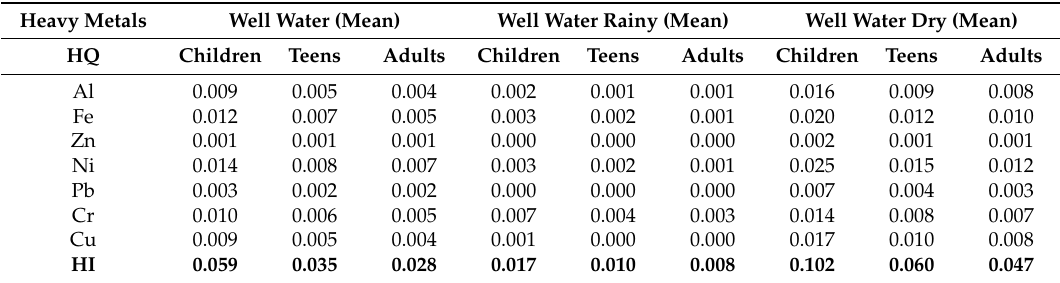
Table 3. Hazard quotient (HQ) and hazard Index (HI), for the water intake of the wells, in the subpopulation of children, adolescents and adults of E. Portes Gil.